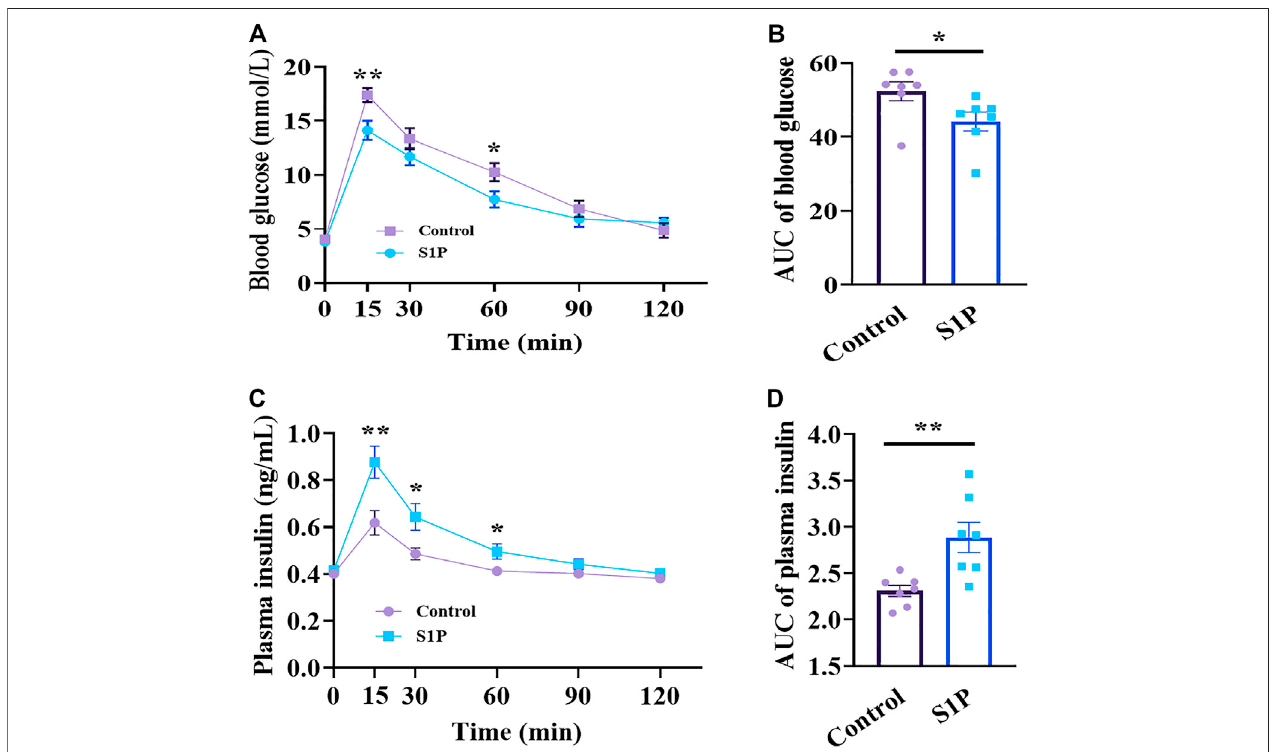
FIGURE 1 | Effects of sphingosine 1-phosphate (S1P) treatment on blood glucose and plasma insulin in vivo . The 8-wk-old C57BL/6 mice were given intraperitoneal injection of S1P (80 μ g/kg) or vehicle. After 10 min, the mice were fed with glucose load (2 g/kg) followed by determination of blood glucose level (A) and plasma insulin concentration (C) at the indicated time points. The AUC values of blood glucose (B) and insulin levels (D) during the OGTT were compared, respectively ( n (cid:2) 7). * p < 0.05, ** p < 0.01 vs control group treated with the vehicle at each time point; by unpaired two-tailed Student ’ s t test. The results represent by the mean ± SEM.